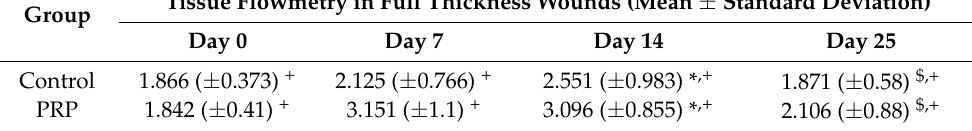
Table 4. Laser Doppler flowmetry measurements in the eight cats. Tissue Flowmetry in Full Thickness Wounds (Mean ± Standard Deviation) Group Day 0 Day 7 Day 14